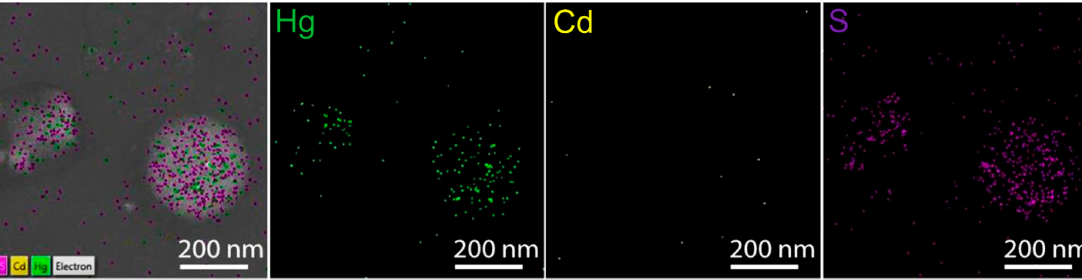
Figure 7. HAADF–STEM–energy-dispersive X-ray spectroscopy (EDS) analysis of the biosynthesized nanoparticles. Layered electron images and elemental maps of Hg, Cd and S are shown.